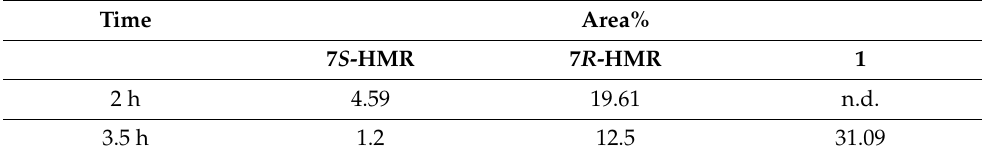
Table 3. HPLC monitoring of the reduction reaction after 3.5